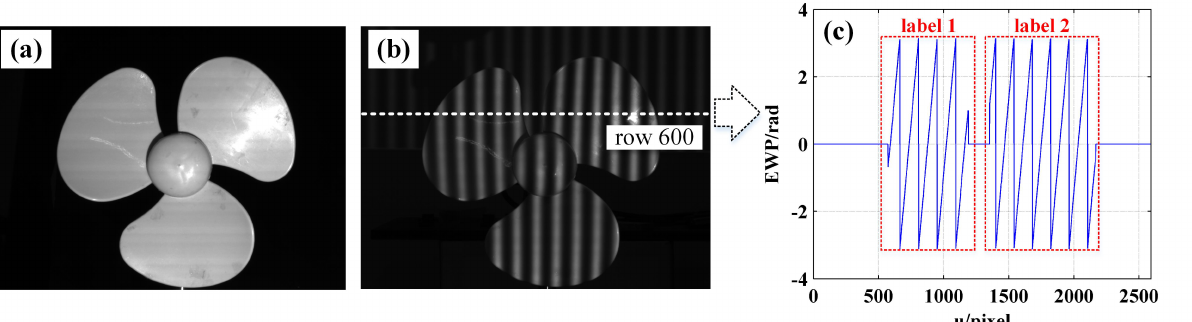
Figure 15. ( a ) Physical map of fan blade; ( b ) sinusoidal fringe image with initial phase of – π captured by camera; ( c ) EWP of row 600.